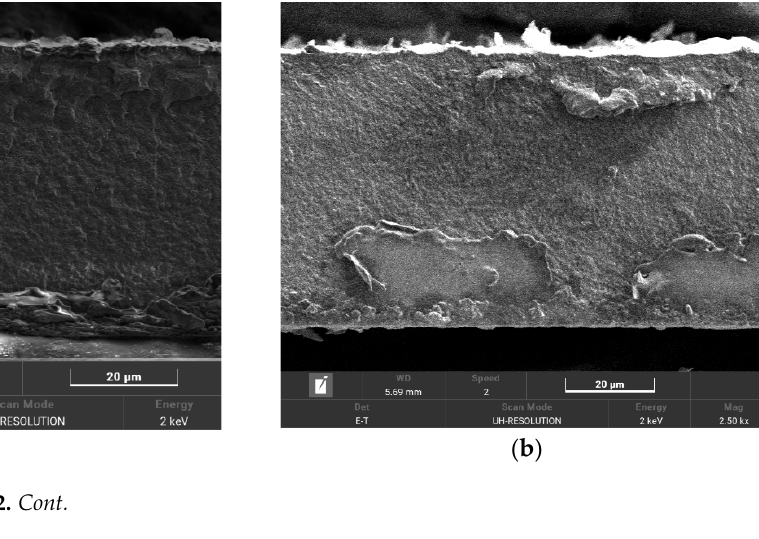
Table 1. Thickness (T), degree of grafting (DG), ion exchange capacity (IEC), hydration numbers (λ), hydrogen permeability (P(H 2 )), and conductivity (σ) of the membranes. Membrane